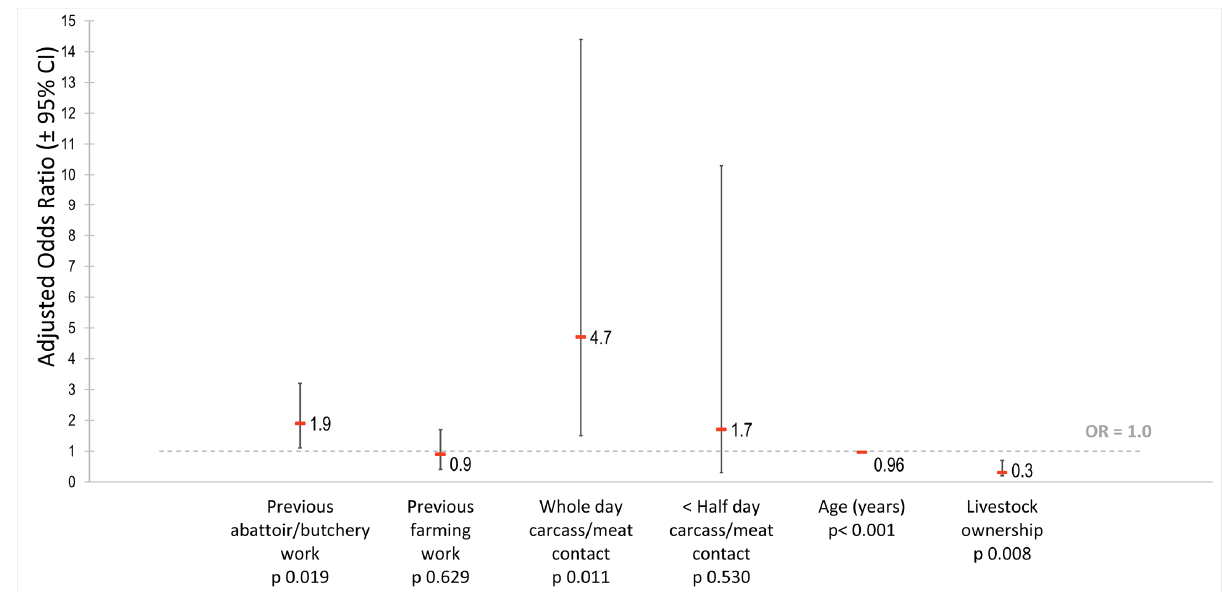
Figure 2. Factors significantly associated with Coxiella burnetii seropositivity in the multivariable logistic regression analysis of the abattoir survey, South Africa, 2018. Table 3. Univariable and multivariable logistic regression analysis for factors associated with Coxiella burnetii seropositivity in the abattoir survey, South Africa,